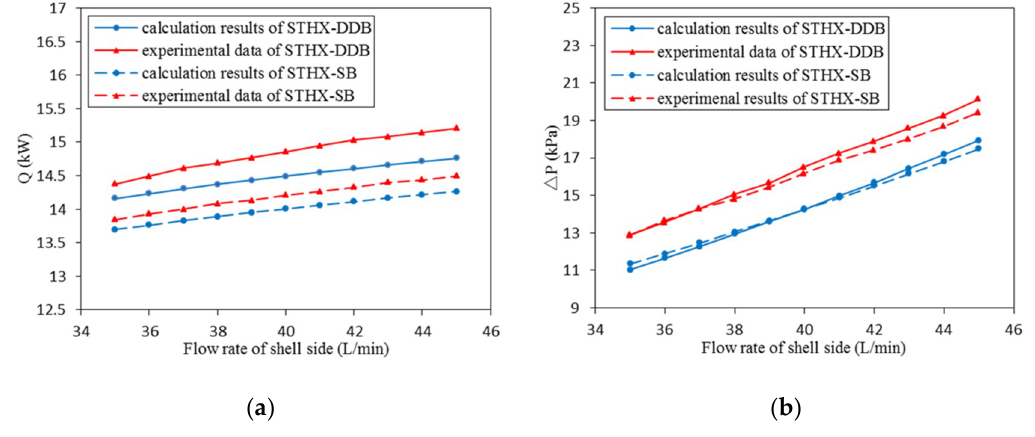
Figure 5. Comparison between calculation results and experimental data: ( a ) heat transfer capacity; ( b ) shell-side pressure drop.